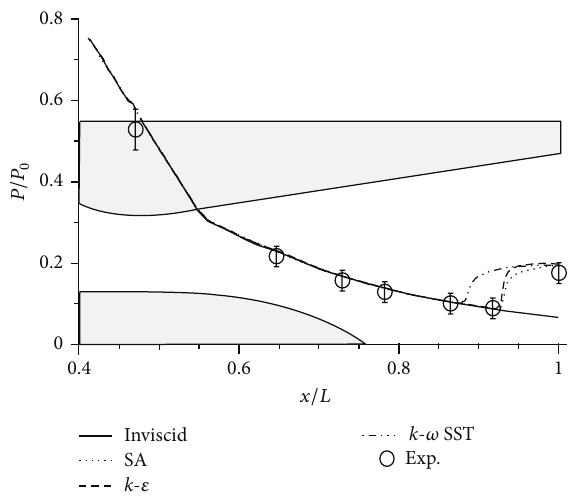
Figure 8: Effect of turbulence model on the pressure distribution. predicted in the shock structure, and negligible difference in the pressure distribution.